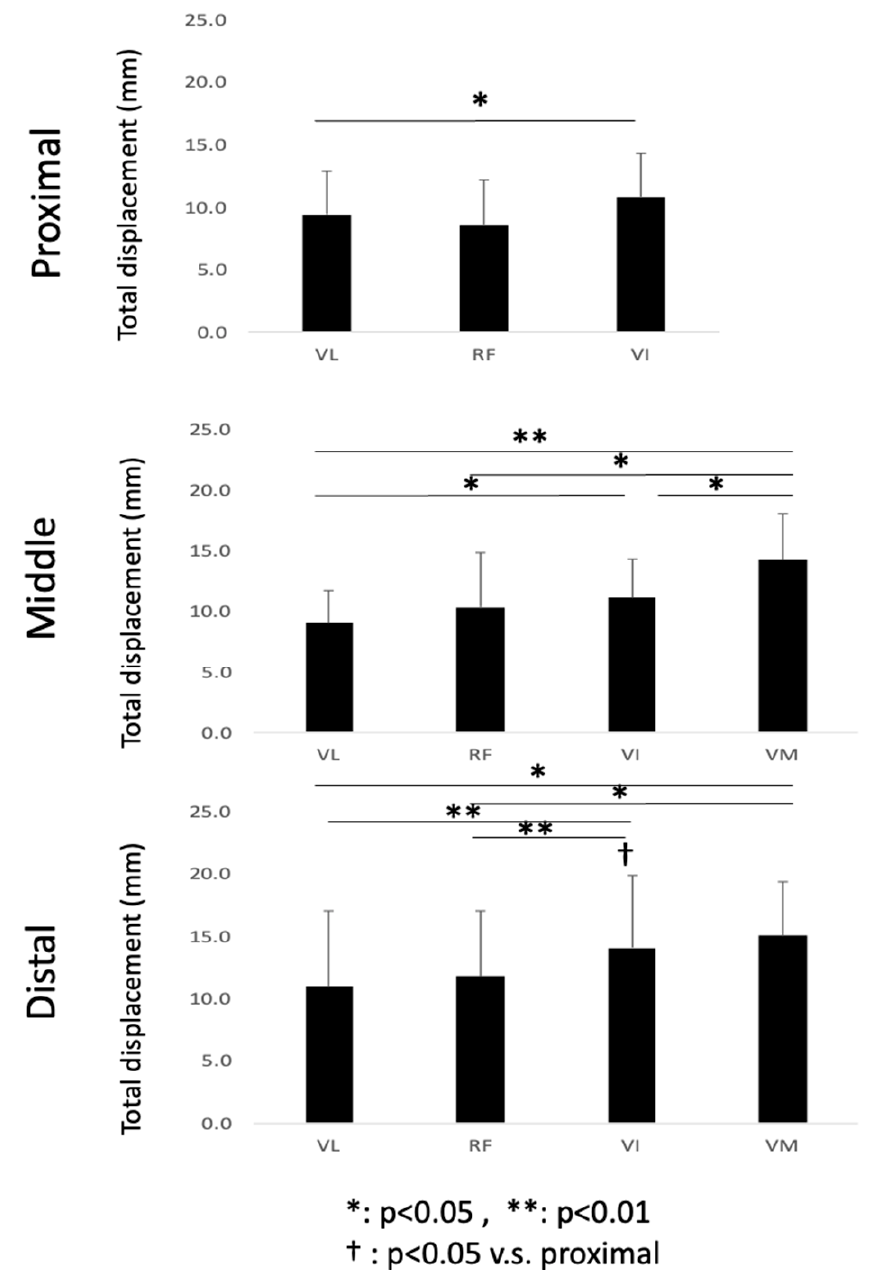
Figure 5. Ensemble mean value of the total displacement of the three sections, proximal, middle, and distal, for the different muscles, VL, RF, VI, and VM.